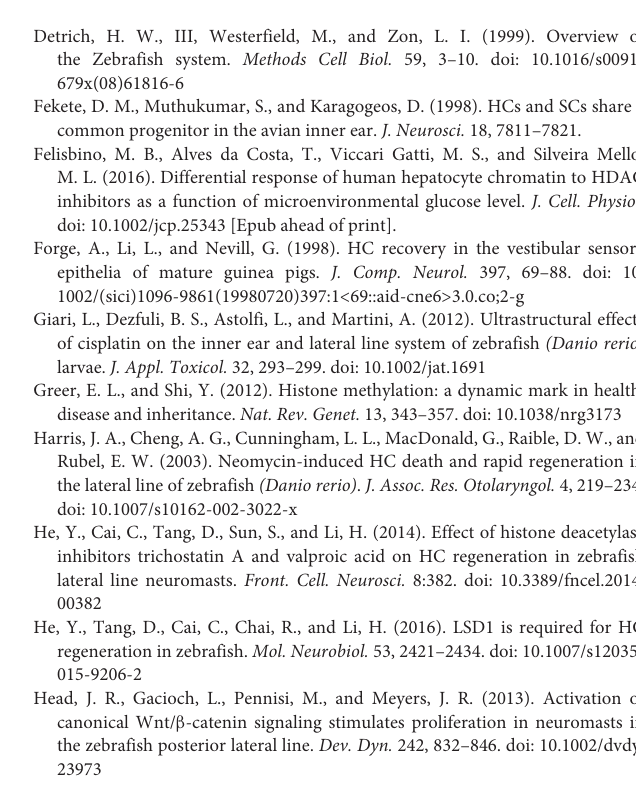
Supplementary Figure 1 | Impact of BIX01294 treatment on apoptosis . Cleaved caspase-3 staining (red) is used to label cell death. HCs are labeled with anti-GFP antibody (green), and nuclei are stained with DAPI (blue). Scale bars = 10 µ m. Supplementary Figure 2 | The representative images for fgf3, wnt4a, wnt10a, atoh1 and